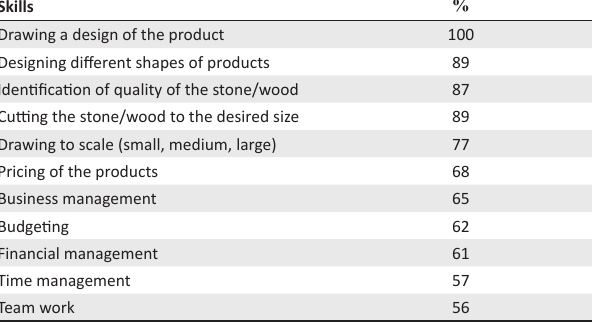
TABLE 2: Skills learned through the training programme. Skills % Drawing a design of the product 100 Designing different shapes of